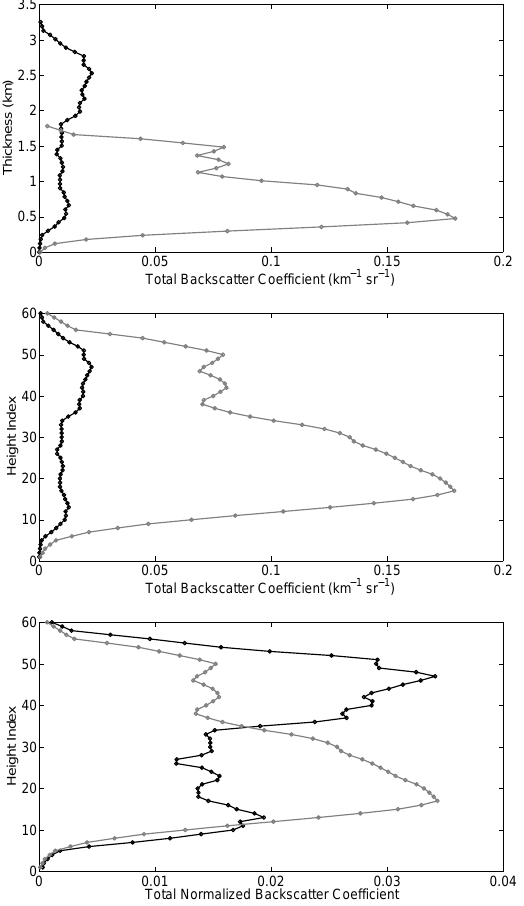
Fig. 2. Pre-processing operations performed on two randomly chosen BSPs. Upper panel: CALIOP BSPs are compared without any manipulation. Middle panel: the backscatter profiles are rescaled to a standard number of points (60 height indexes). Lower panel: the two BS profiles are normalized to unit area as functions of the height index.